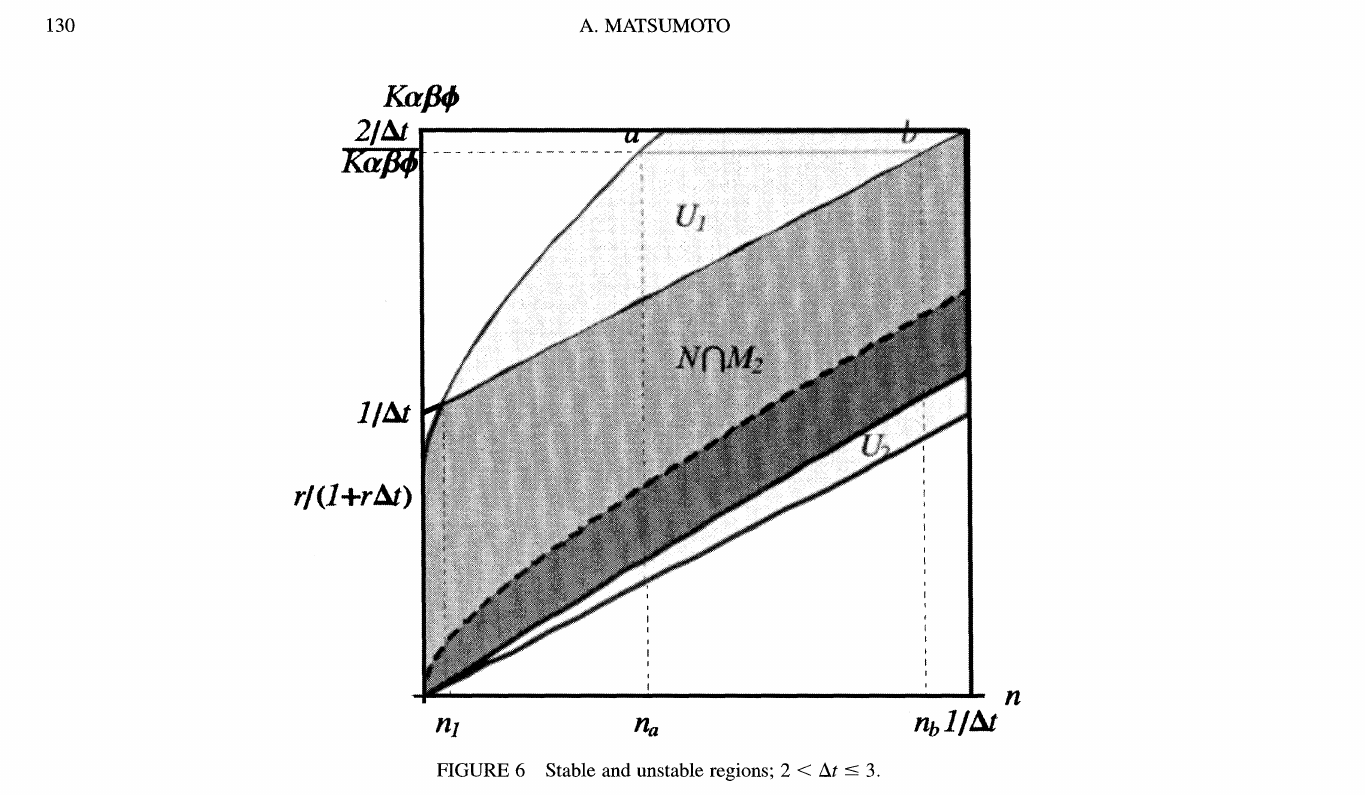
FIGURE 6 Stable and unstable regions; 2 < At _<